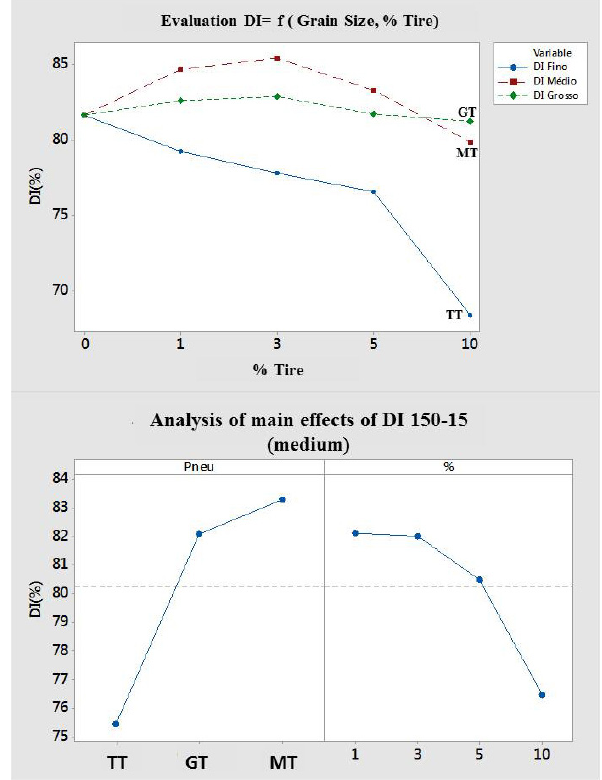
Figure 5. Variation of DI 150-15 coke regarding the percentages and tires